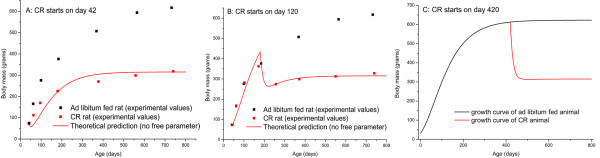
Growth curves of ad libitum fed and CR rats. (A) CR starts after d 42; (B) CR starts after d 120; (C) Theoretical prediction of growth curve when CR starts in adulthood (data on ad libitum fed animals from Table 1).